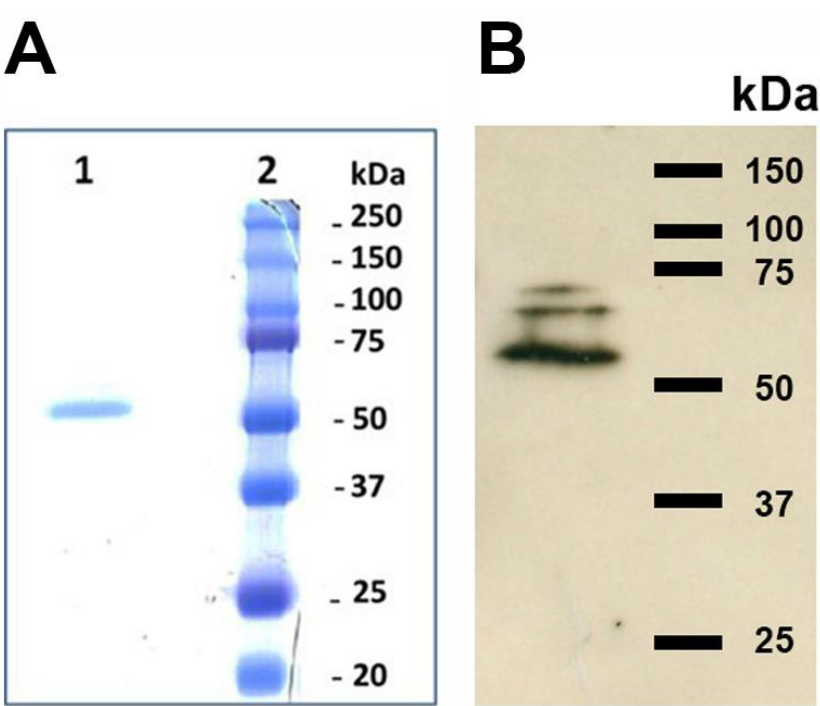
Figure 3. 10% SDS-PAGE (panel A ) of the purified TGase and Western blot (panel B ). Lane 1, fraction obtained from the affinity chromatography on Heparin-Sepharose; lane 2, molecular mass marker. (please find the WB full membrane in Figure